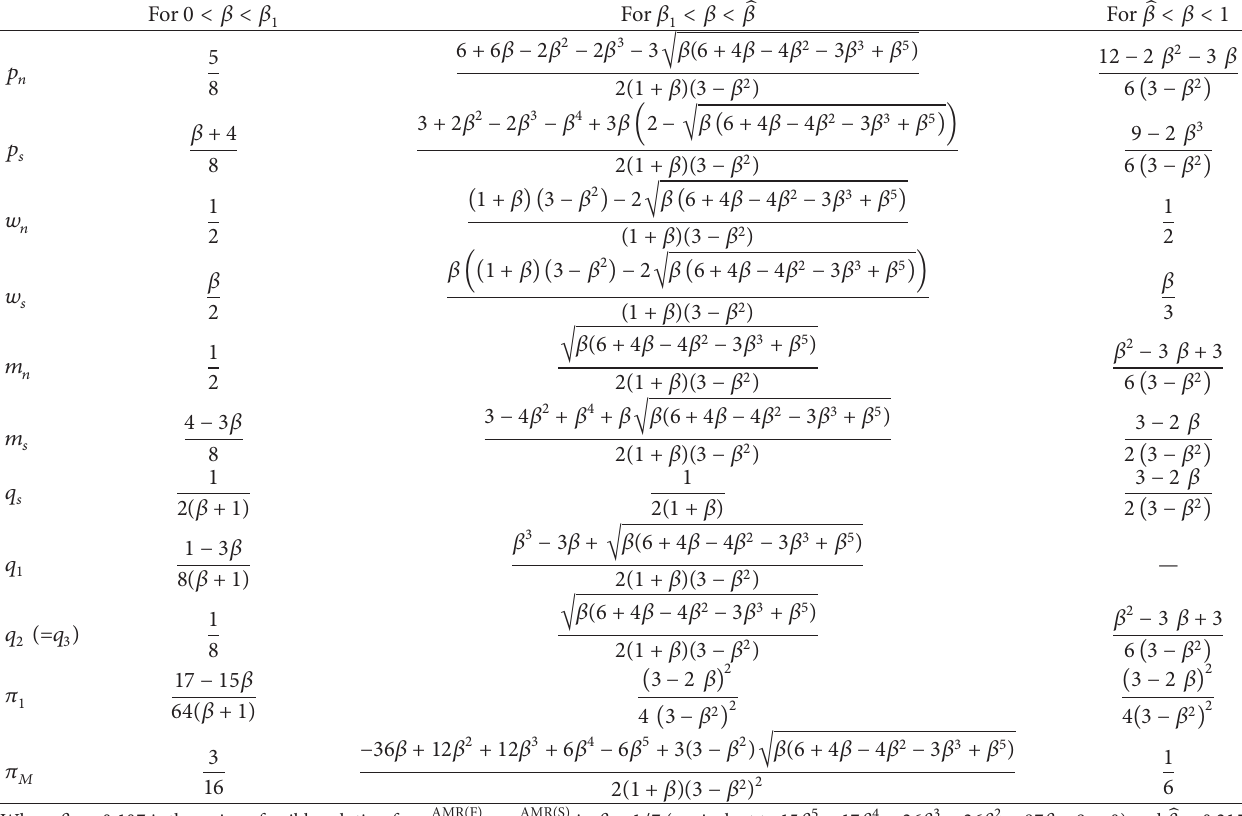
Table 9: Equilibrium outcome under MAR scenario.